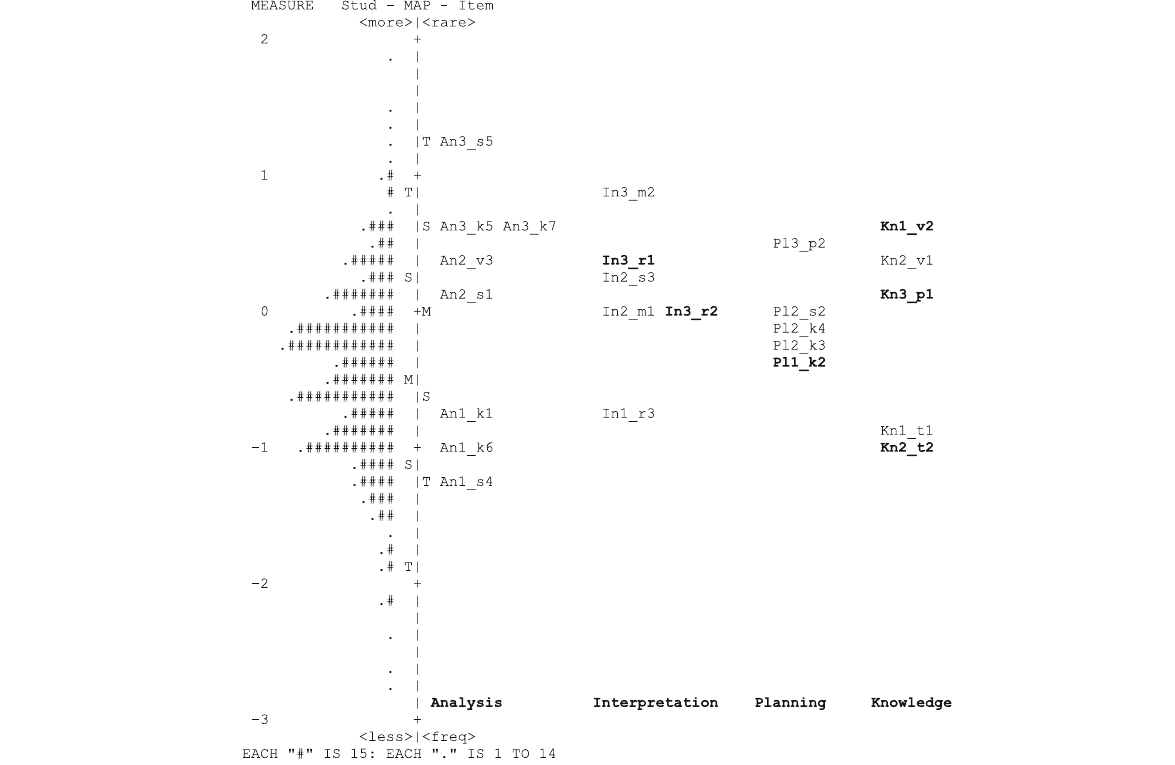
Fig. 3 The WrightMap presenting difficulty of SIT-PE items and distribution of student abilities. M on the left side of the vertical scale — average ability of students participating in the study. M on the right side of the vertical scale — average difficulty of items included in the study. S on the left side of the vertical scale — one standard deviation from the average ability of students. S on the right side of the vertical scale — one standard deviation from the average difficulty of items. T on the left side of the vertical scale — two standard deviations from the average ability of students. T on the right side of the vertical scale — two standard deviations from the average difficulty of